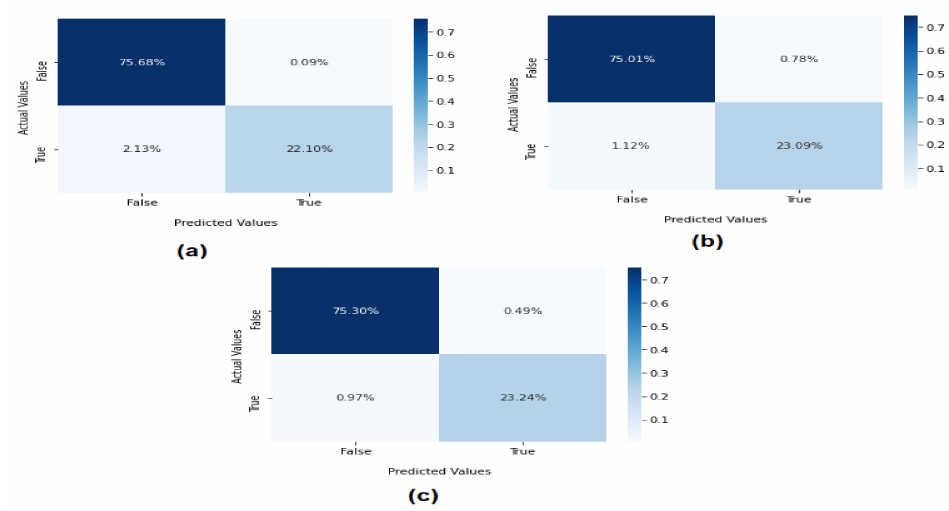
Figure 6. Confusion metrics of machine learning on binary classification: ( a ) SVM, ( b ) KNN, and ( c ) RF.